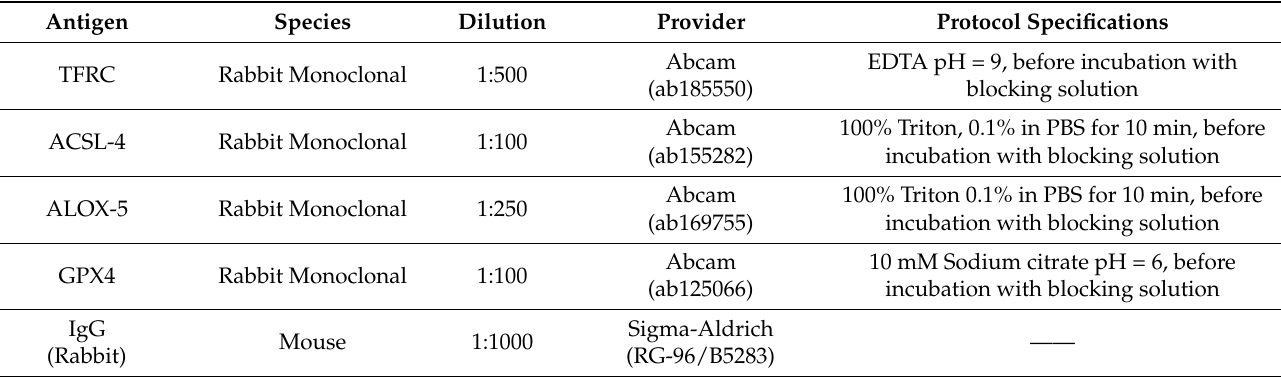
Table 2. Primary and secondary antibodies used and their